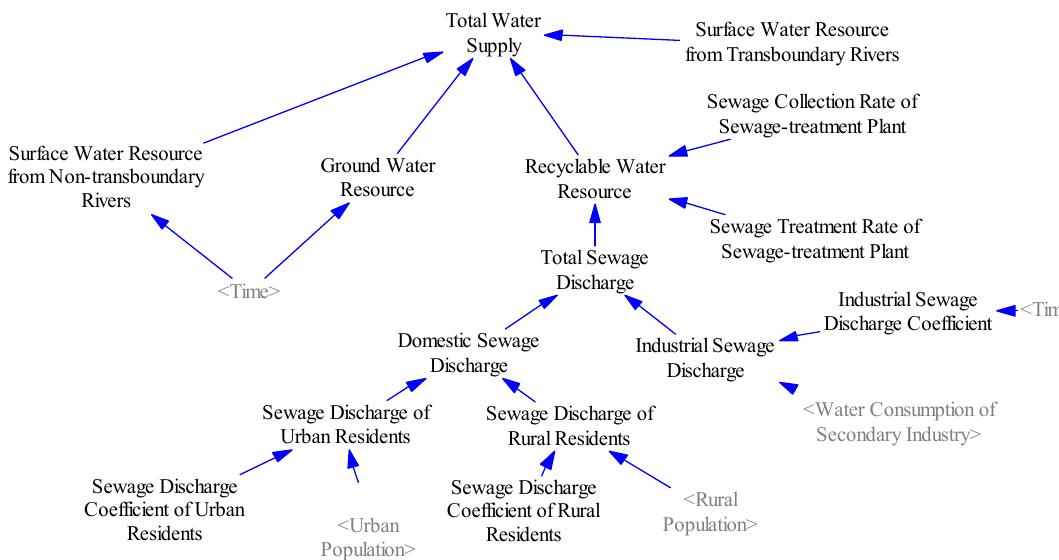
Figure 4. System dynamics flowchart of the water resource supply subsystem.